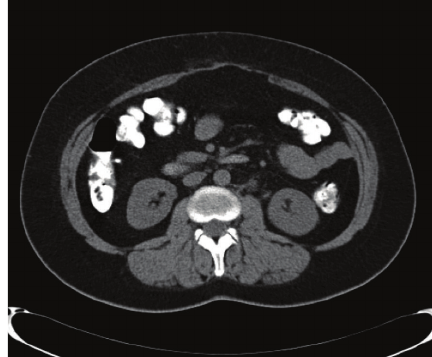
Figure 3: Abdominal computed tomography (CT) scan one year after the operation; the postoperative site is free of recurrent